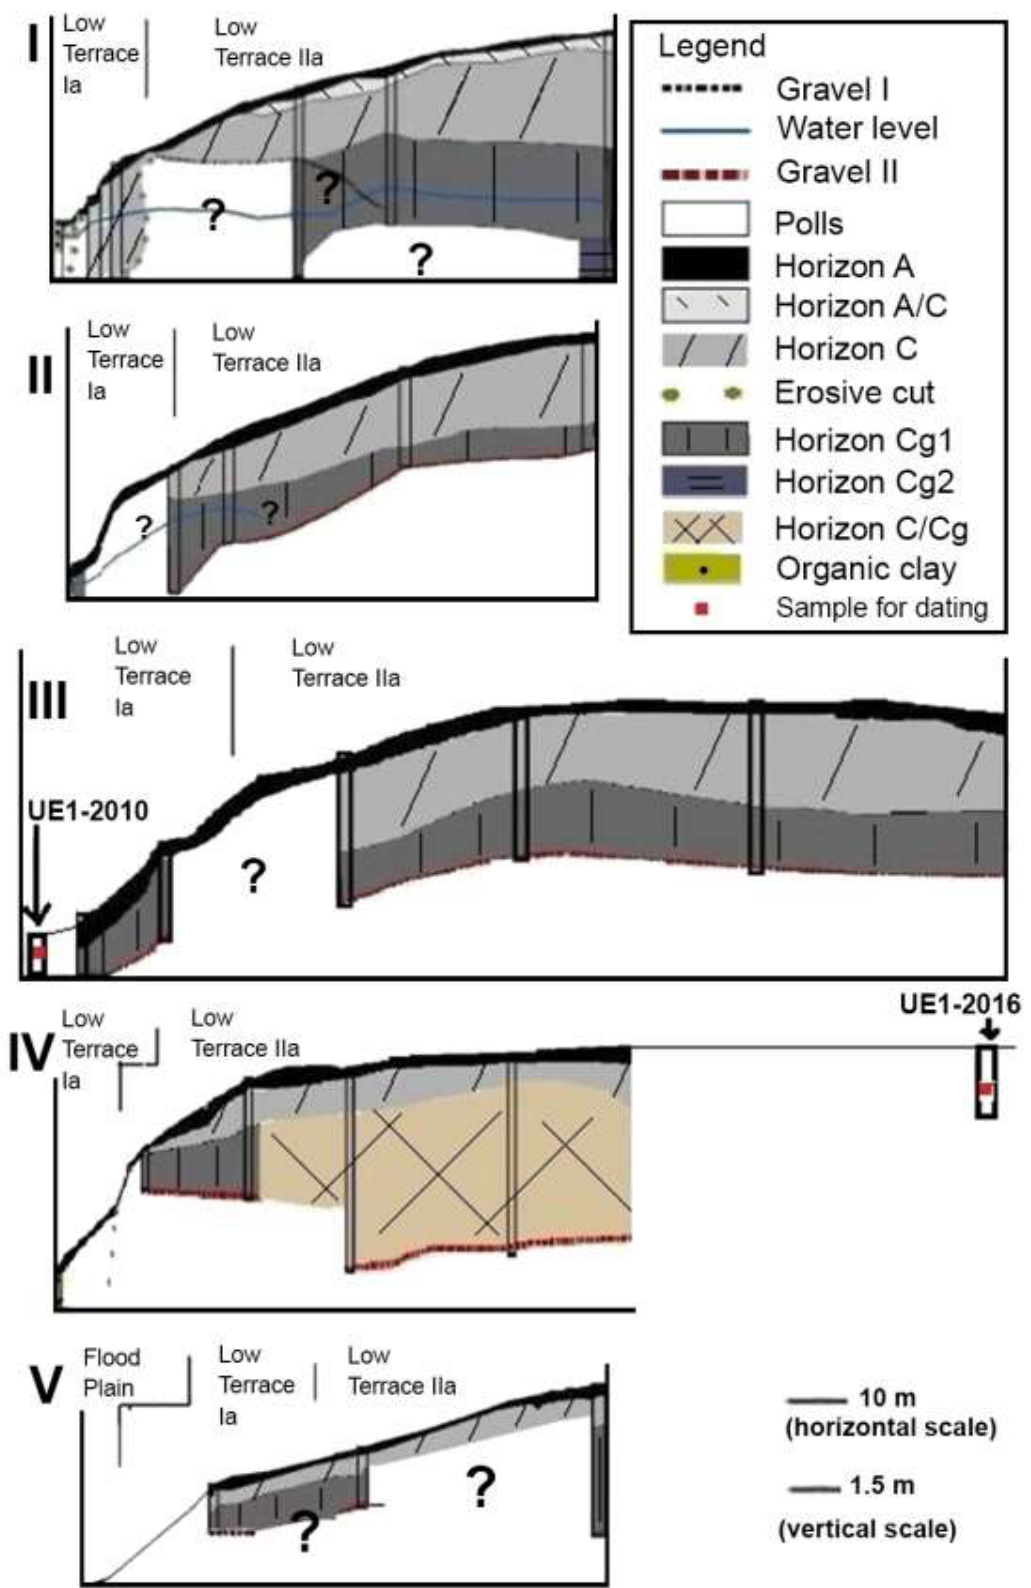
Figure 11. Context of the sites selected for detailing the surface coverage of BES II. Source: adapted from Cheliz